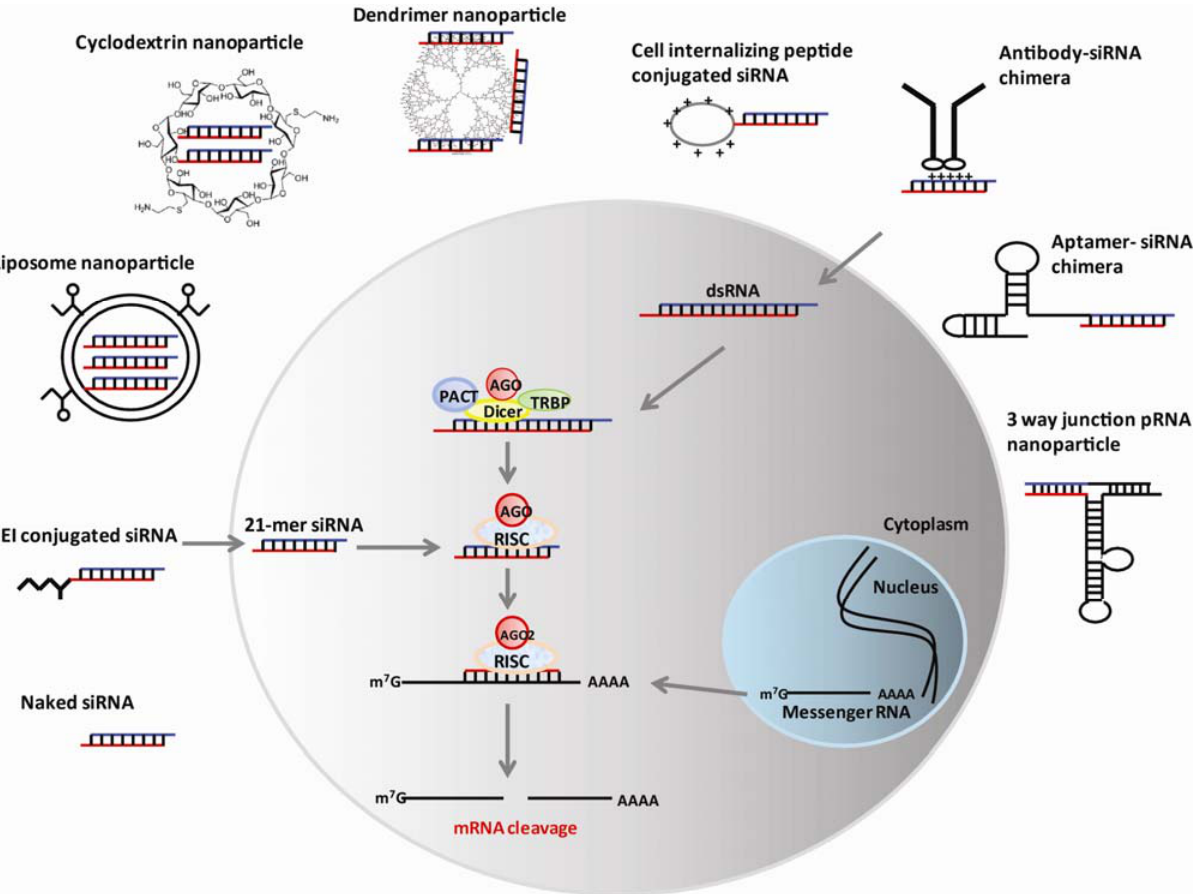
Figure 1. The mechanism and delivery strategies for RNA interference. RNAi therapeutics (e.g., siRNA) can be internalized into the cell via different delivery vehicles. Exogenously introduced long dsRNA are processed into ~21nt siRNA duplex by the Dicer/TRBP complex. Subsequently, siRNA duplexes associate with the Ago proteins and are loaded into the RISC where the passenger (sense) strand is removed and the guide (antisense) strand remains to target mRNA for silencing. The resulting mature RISC complex silences inhibiting the translation of the